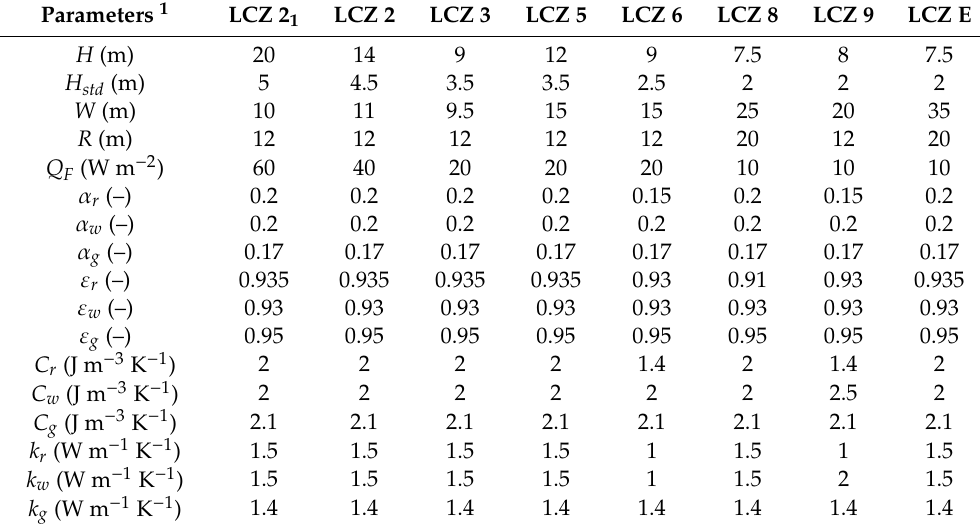
1 Subscripts correspond to: r : Building roof, w : Canyon wall and g : Canyon